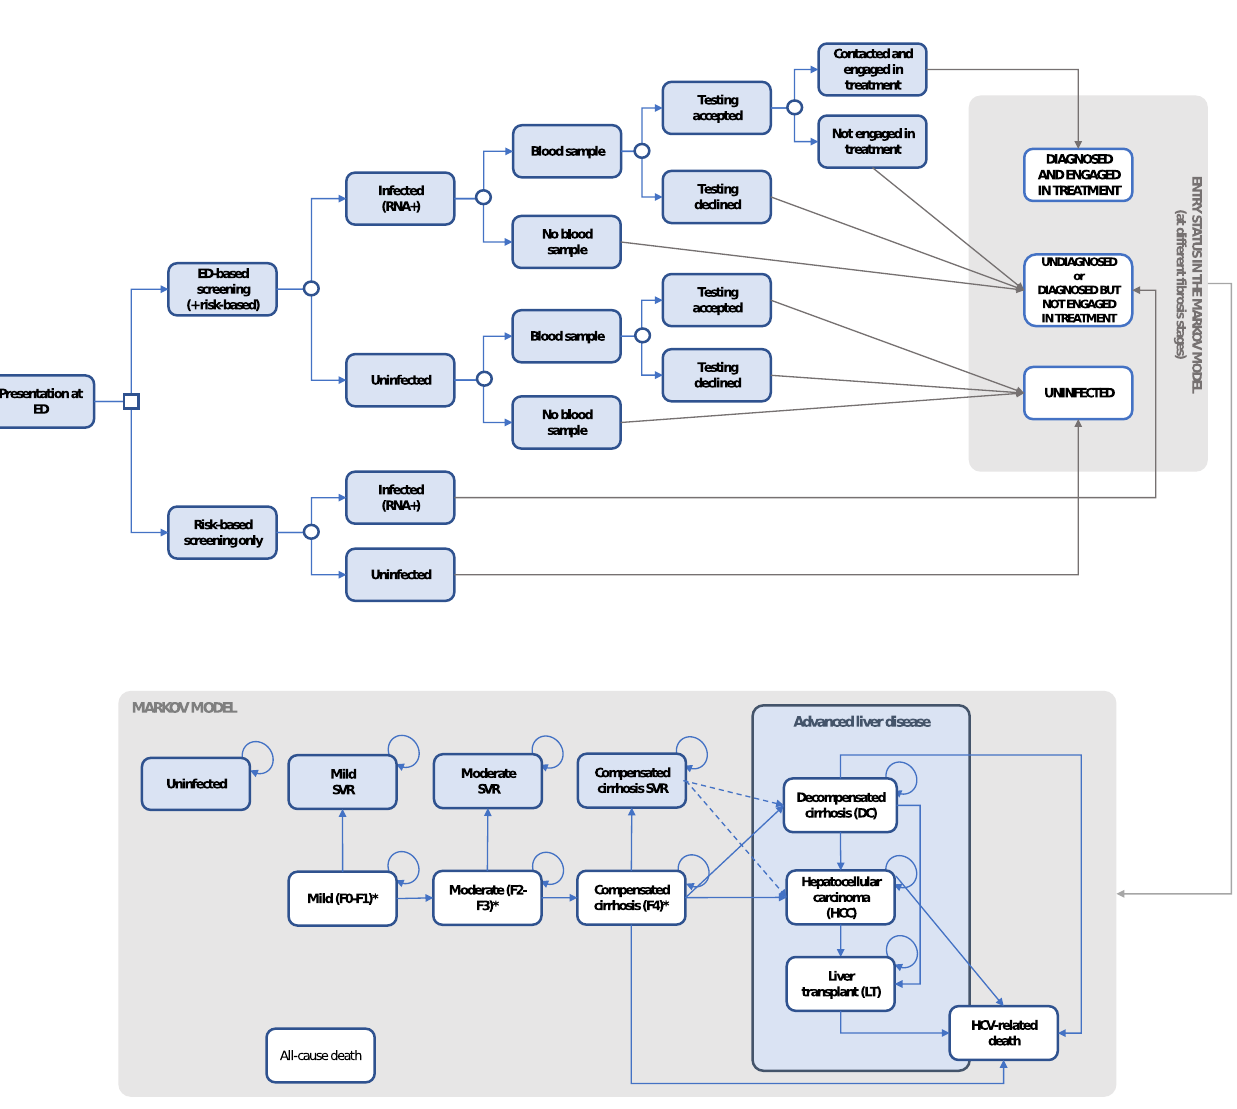
Fig 1. Model overview. � Individuals who are undiagnosed, untreated or who fail to achieve SVR after two treatment attempts. Dotted lines are indicative of slower